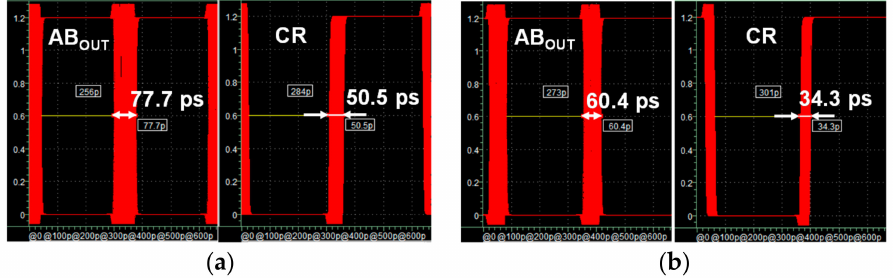
Figure 12. Simulation results of ALDE for random data: ( a ) AB OUT and CR without adaptive level-dependent equalization; ( b ) AB OUT and CR with adaptive level-dependent